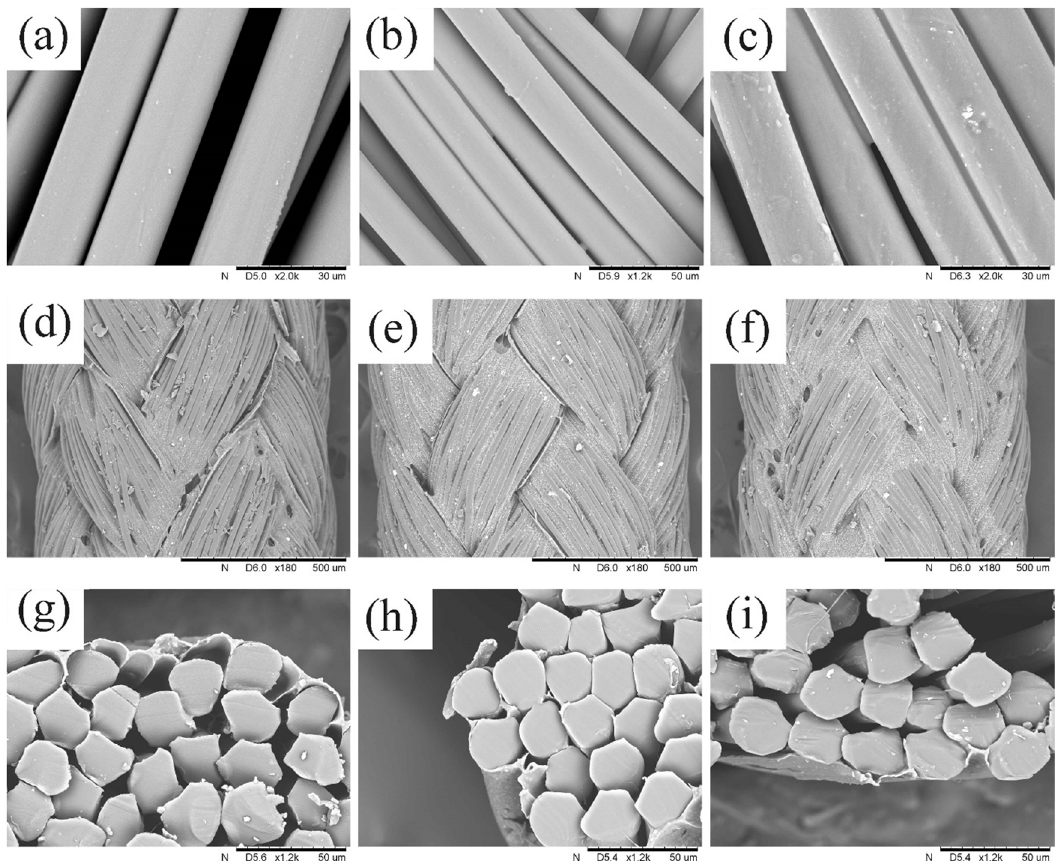
Figure 7: ( a ) Uncoated harness cord. ( b ) 0.5% PU - coated harness cord. ( c ) 1.5% PU - coated harness cord. ( d ) Surface morphology of coated harness cord with PVA. ( e ) Surface morphology of coated harness cord with PU ( 0.5% ) /PVA. ( f ) Surface morphology of coated harness cord with PU ( 1.5% ) /PVA. ( g ) Cross section of coated harness cord with PVA. ( h ) Cross section of coated harness cord with PU ( 0.5% ) /PVA. ( i ) Cross section of coated harness cord with PU ( 1.5% ) /PVA.